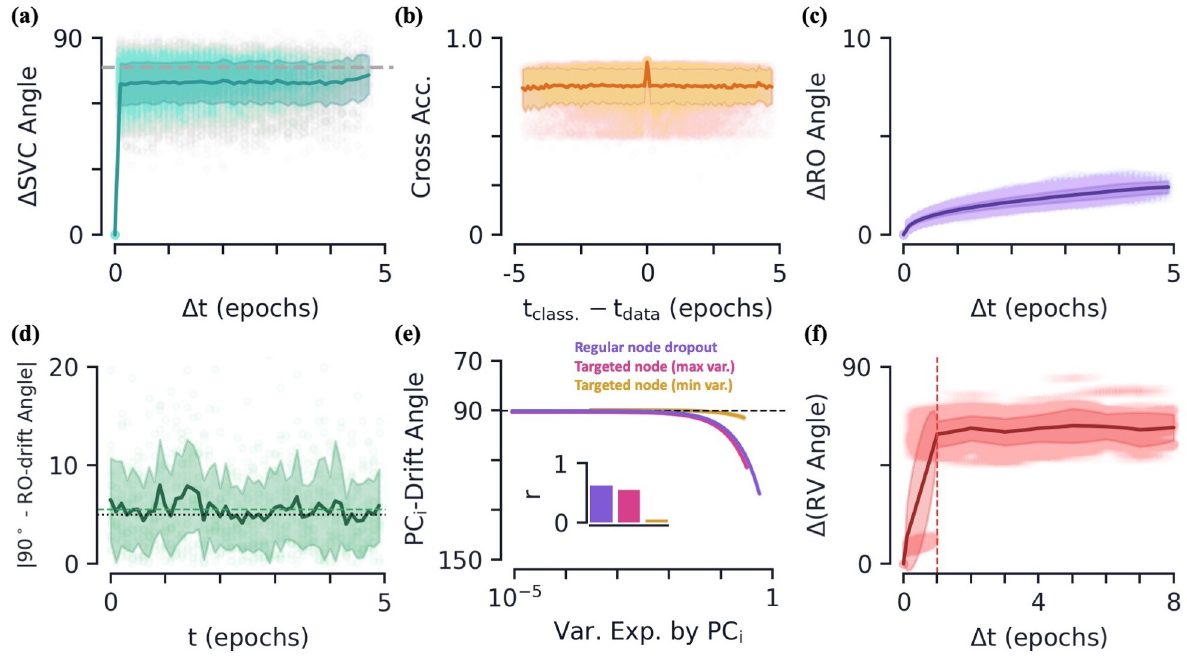
Fig 6. Artificial neural networks: Additional properties of drift geometry. [a-d] Various quantities as a function of relative/absolute training time (in epochs). Means are shown as dark lines, with 95% confidence intervals shaded behind. Raw data is scattered behind. (a) Angle between SVC classifiers (normal vectors) as a function of the time difference. The grey dashed line is the average for the novel Hit data shown in Fig 4g. (b) Cross classification accuracy as a function of time difference between classifier training time (Class.) and testing time (Data). (c) Difference in angle of a stimulus group’s readout as a function of the time difference. Note the different vertical scale from (a). (d) Deviation of the angle between a stimulus group’s drift and the respective readout from perpendicular (i.e. 90 degrees). The dashed green line is the average across time. The dotted black line is the angle between two randomly drawn vectors in a feature space of the same dimension. (e) Fits of variance explained versus angle of drift with respect to PC direction for regular node dropout (purple), targeted maximum variance node dropout (pink), and targeted minimum variance node dropout (yellow). The inset shows the r -values of the respective fits. (f) Difference in response vector angle as a function of Δ t . The dashed vertical line indicates the time scale on which the node dropouts are updated (1/epoch).